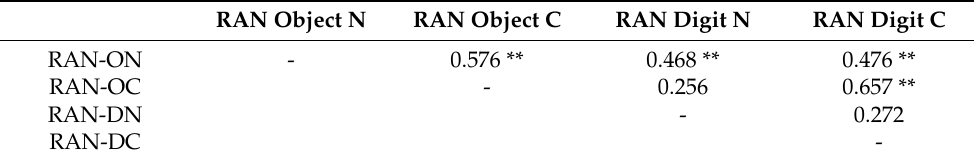
Table 9. Pearson’s correlations of total naming times recorded across all the RAN-related